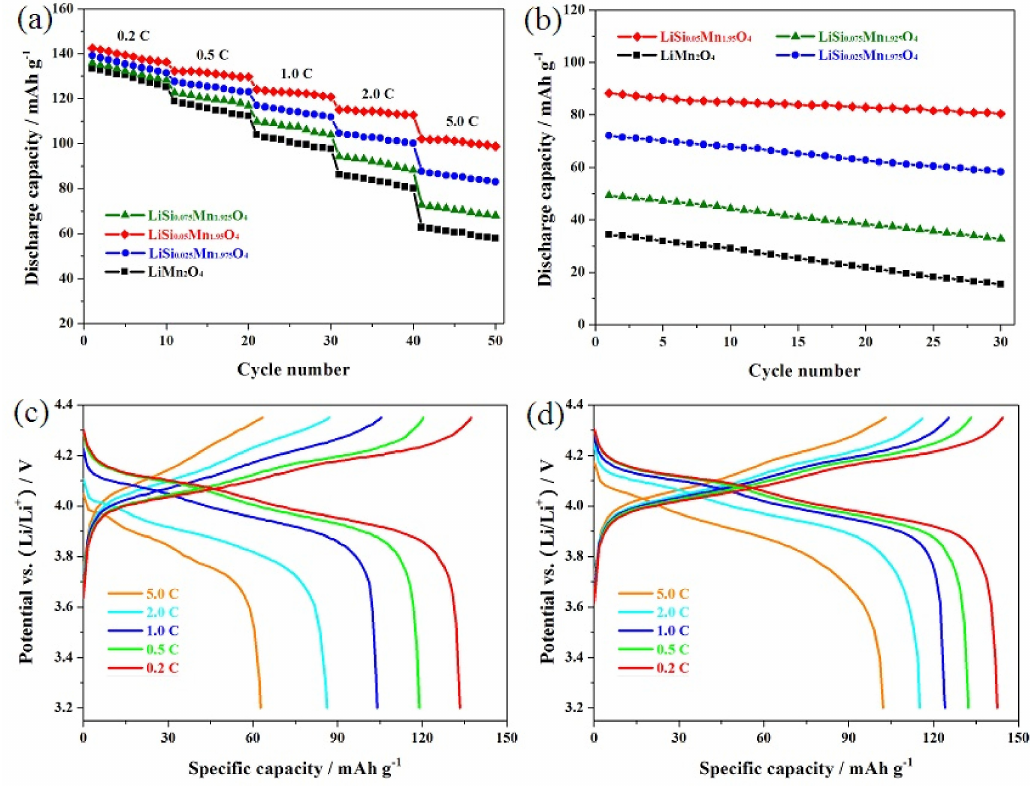
Figure 6. ( a ) Rate performance of the LiSi x Mn 2 − x O 4 (x = 0, 0.025, 0.05, 0.075) samples; ( b ) Cycling performance of the LiSi x Mn 2 − x O 4 (x = 0, 0.025, 0.05, 0.075) samples at the higher discharge rate of 10 C; Representative charge-discharge curves of the LiMn 2 O 4 ( c ) and LiSi 0.05 Mn 1.95 O 4 ( d ) samples at varying rates of 0.2–5.0